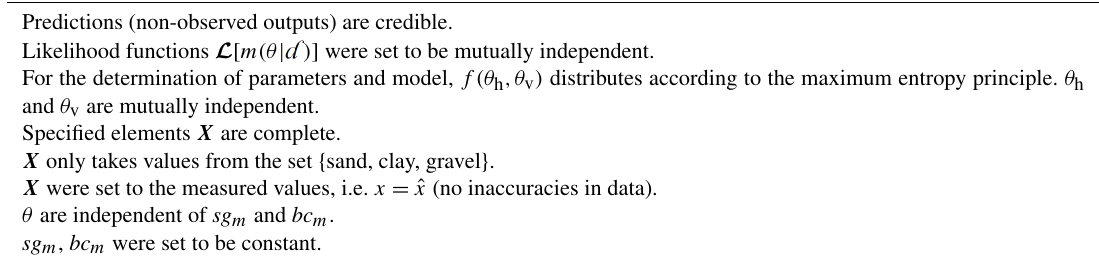
Table 4. Assumptions enforced by Zhao et al. (2021). Predictions (non-observed outputs) are credible. Likelihood functions L [ m(θ | ) ] were set to be mutually